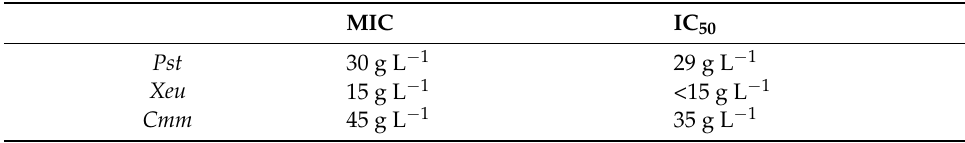
Table 1. Minimal inhibitory concentration (MIC) and half-inhibitory concentration (IC 50 ) of the dried eucalyptus leaf extract for Pseudomonas syringae pv. tomato DC3000 ( Pst ), Xanthomonas